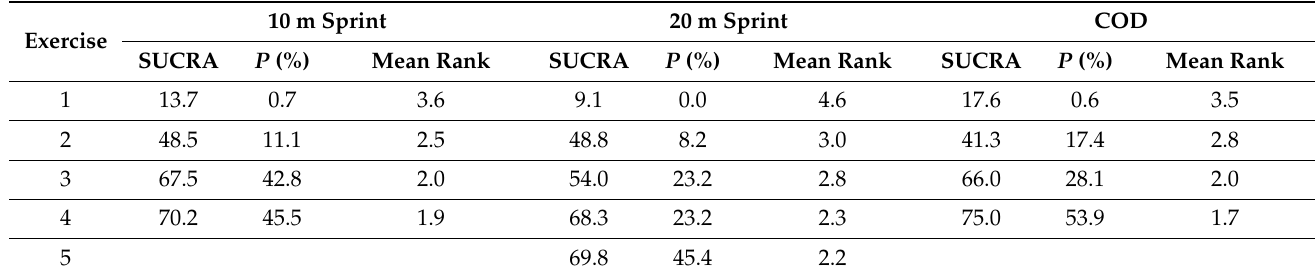
Table 3. Rankings for 10 m sprint, 20 m sprint, and COD for different types of exercise.